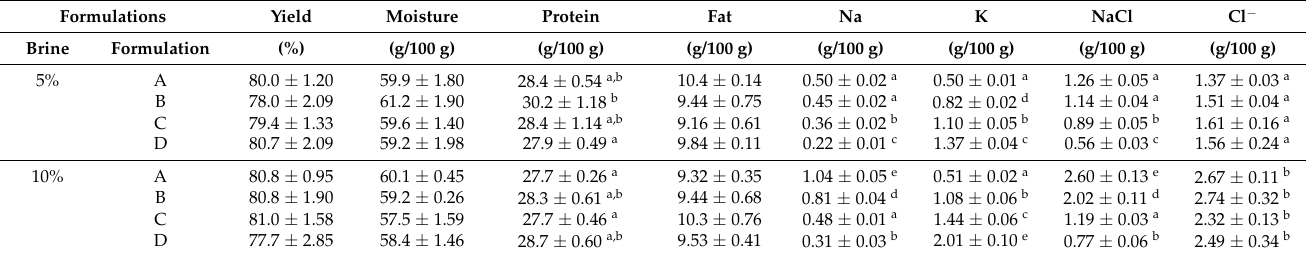
Table 1. Yield, moisture, protein, fat, sodium (Na), potassium (K), sodium chloride (NaCl) and chloride (Cl − ) (g/100 g) in smoked mackerel